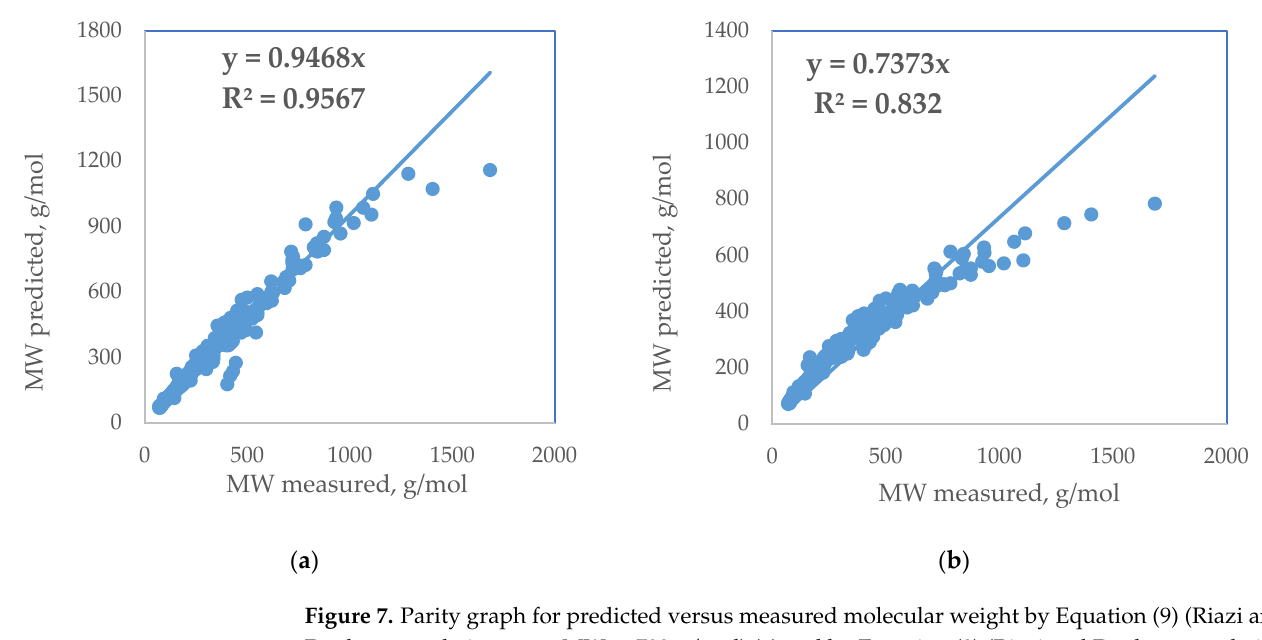
Figure 7. Parity graph for predicted versus measured molecular weight by Equation (9) (Riazi and Daubert correlation up to MW ≤ 700 g/mol) ( a ) and by Equation (8) (Riazi and Daubert correlation up to MW ≤ 300 g/mol) ( b ).